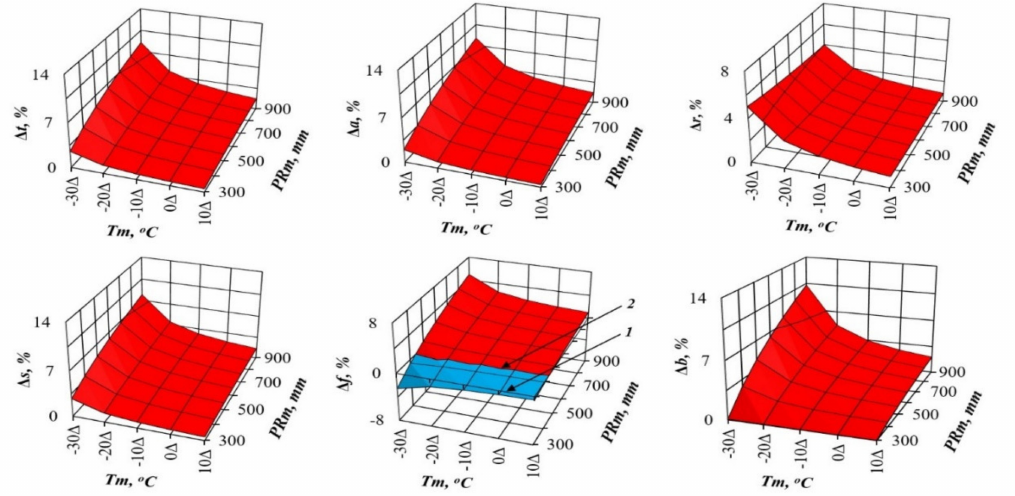
Figure 4. The theoretical changes in pine biomass in relation to the assumed warming increase of 1 ◦ C based on the model (1) for the stands aged 100 years. Here and further: 1—the plane corresponding to zero change in biomass at the expected temperature increase by 1 ◦ C; 2—the line of the di ff ering of positive and negative changes in biomass ( ∆ , %) with an expected increase in temperature of 1 ◦